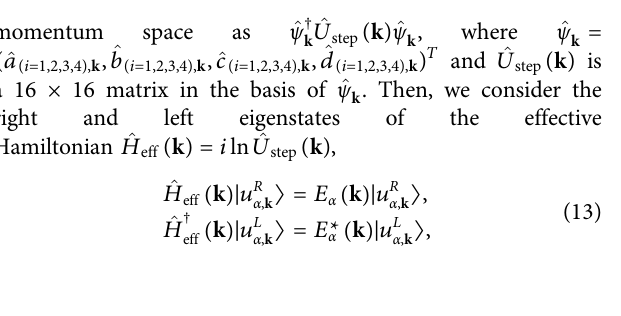
Frontiers in Physics |